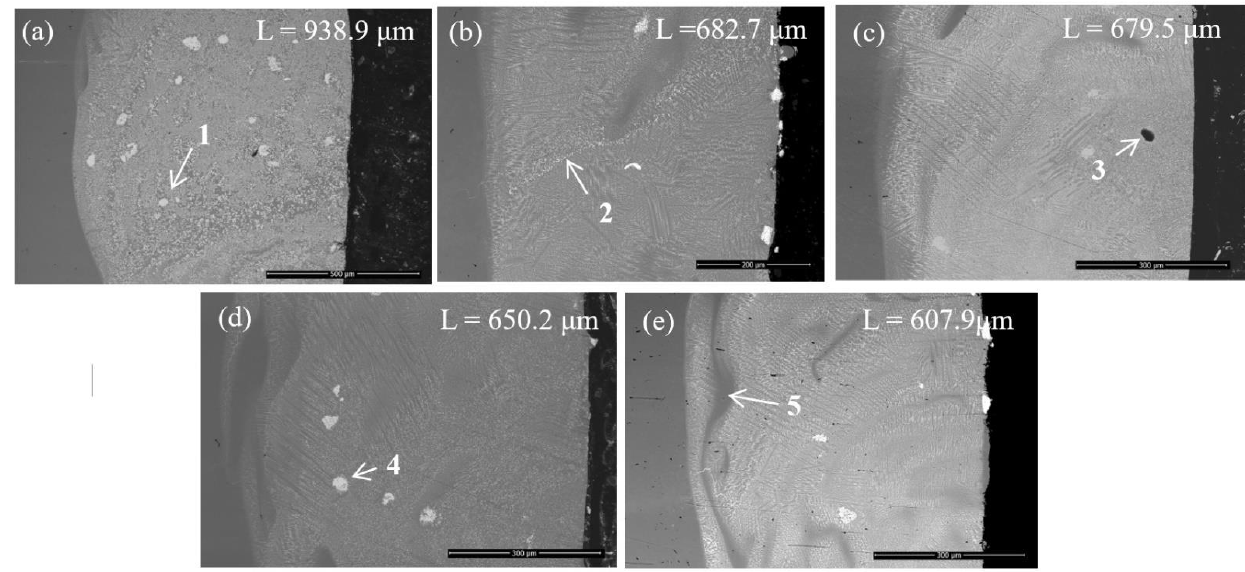
Figure 3. Back scattered electron micrographs of laser cladded WC-Co/NiCrBSi coatings indicating the morphology and thickness of coatings. Sample 1 (a), Sample 2 (b), Sample 3 (c), Sample 4 (d)and Sample 5 (e).